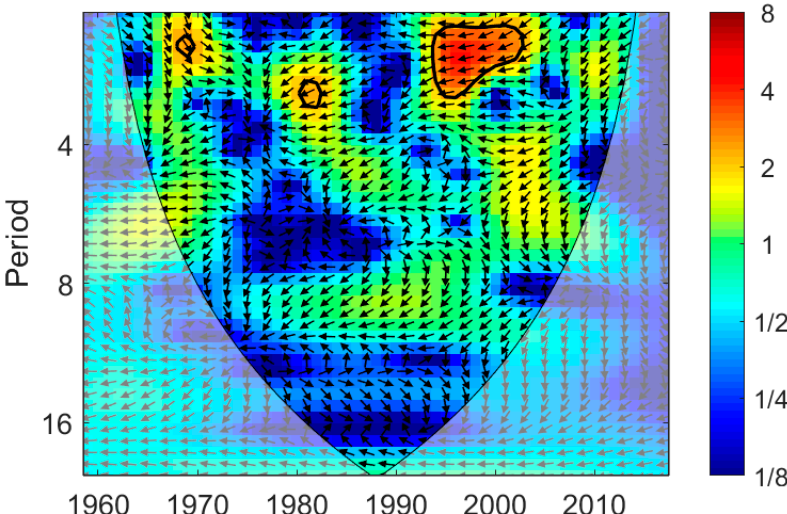
Figure 6. The time-frequency spectrums of the Cross Wavelet Transform (XWT) between summer precipitation and EASMI in the PYLB. The arrows represent relative phase differences. The arrow to the right indicates consistency of phase changes. The arrow to the right indicates the opposite change of phases. The thick black lines represent that the wavelet power spectrums enclosed by them passed confidence test at the 0.05 level. The thin black line is the influence cone, wherein the power spectrums are valid. The unit of the power spectrums is dimensionless power/variance ratio.